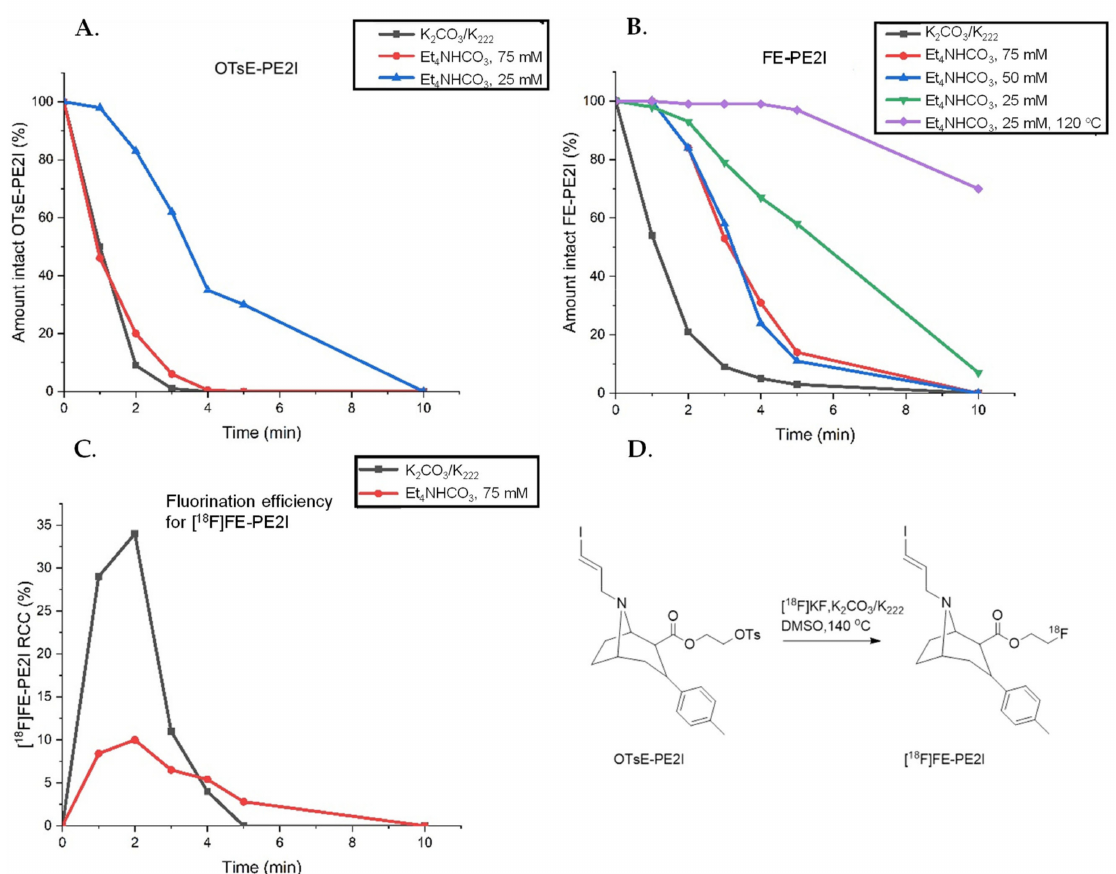
Figure 1. ( A ) Stability of the tosylate precursor (OTsE-PE2I) evaluated in DMSO at 140 ◦ C added to the dried QMA/PS-30 eluate. ( B ) Stability of the reference FE-PE2I evaluated in DMSO at 140 ◦ C (if nothing else is stated) added to the dried QMA/PS-30 eluate. ( C ) Radiochemical conversion for [ 18 F]FE-PE2I using QMA/K 2 CO 3 /K 222 or PS-30/Et 4 NHCO 3 elution in DMSO at 140 ◦ C over time. ( D ) Radiolabeling reaction to form [ 18